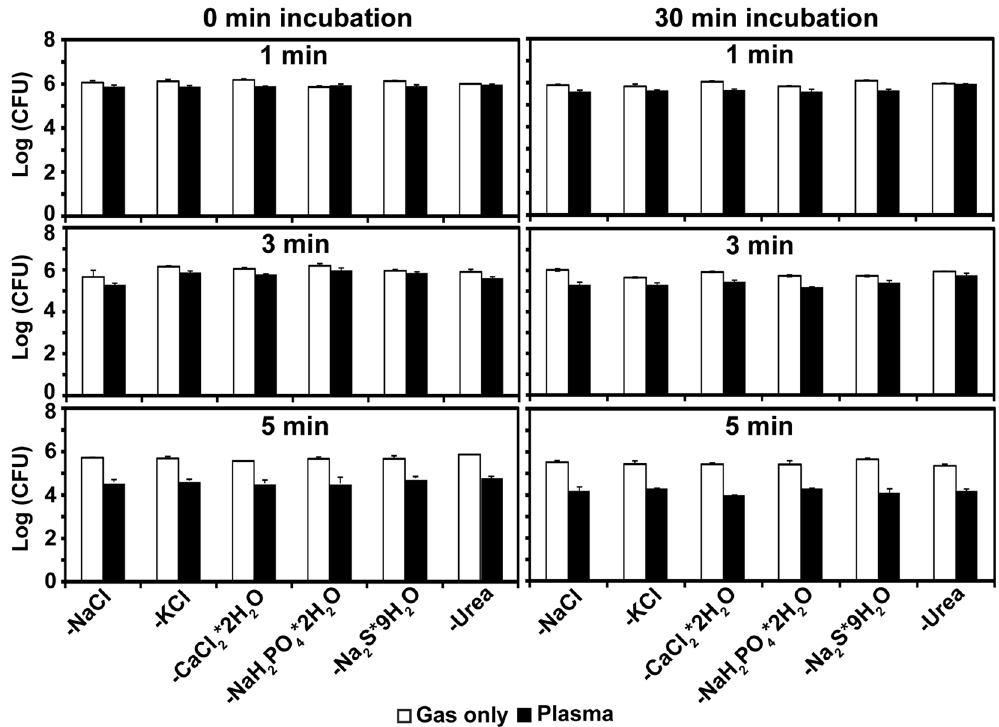
Figure 5. Bacterial viability, as determined by CFU on a log scale after gas or plasma treatment for 1 min, 3 min, or 5 min in saline and artificial saliva missing components. All values are means ± standard deviations of triplicate measurements.